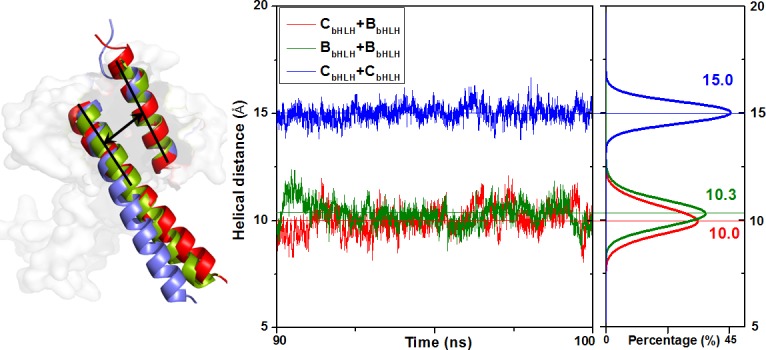
The helical distances in the binary models.The helical distances (Å) between the H1 and H2 helices in the CbHLH+BbHLH (red), BbHLH+BbHLH (green), and CbHLH+CbHLH (blue) models.